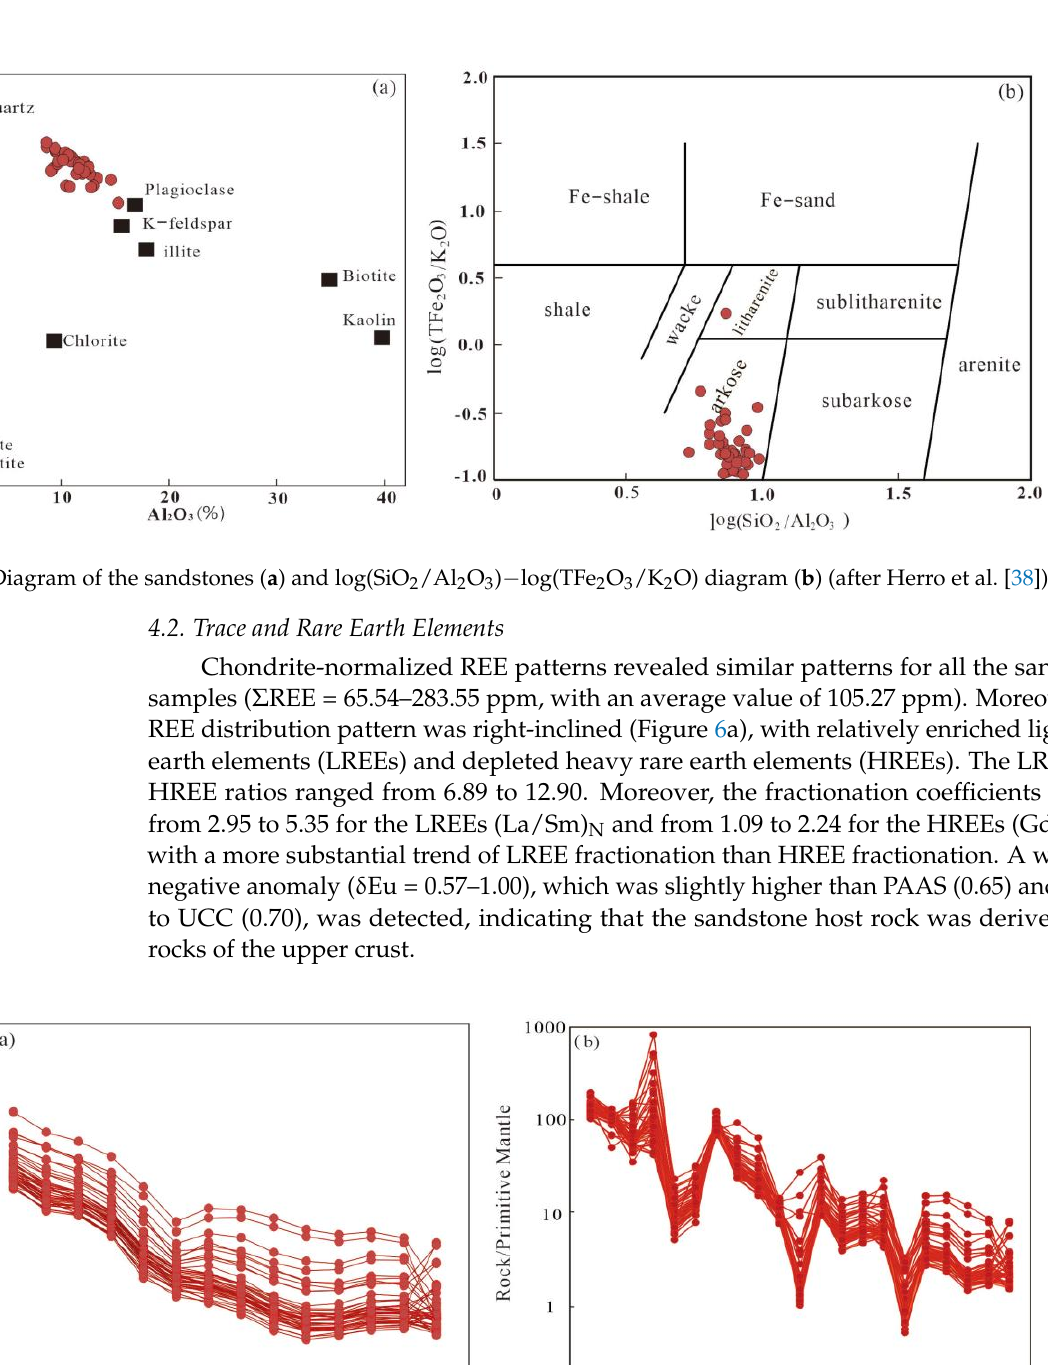
Figure 6. Chondrite normalized REE pattens ( a ) and primitive mantle normalized trace element spider diagrams ( b ) for the Sandstones in northern Songliao Basin (after Sun, S.S. and McDonough. [39]).